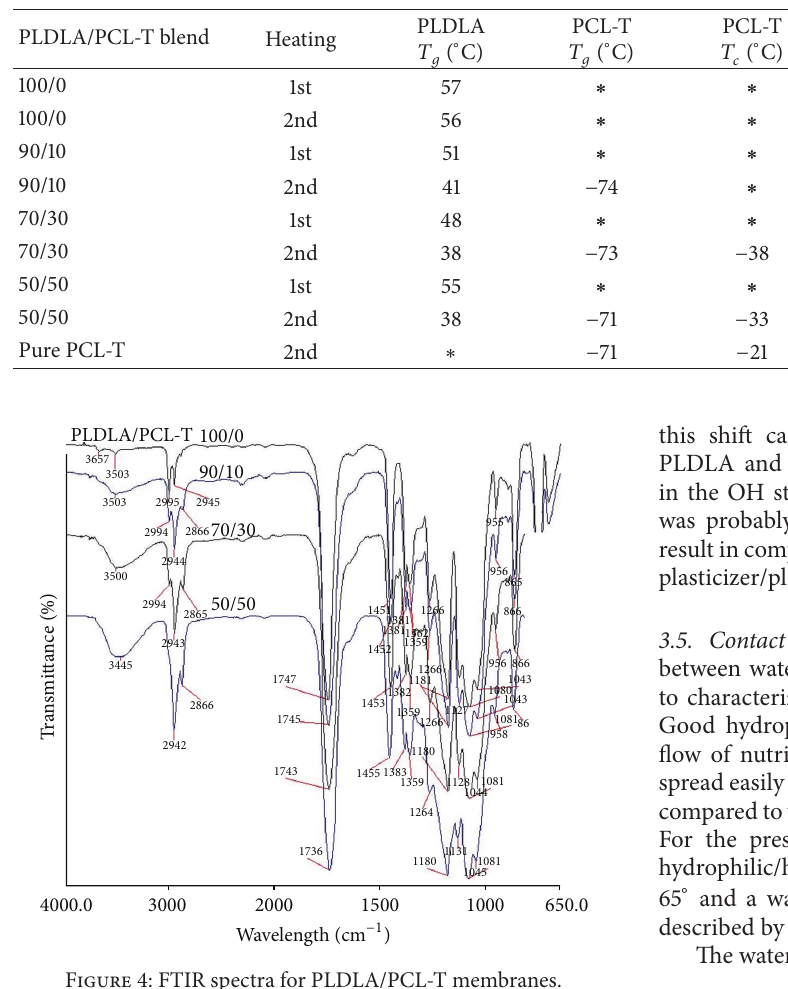
is a consequence of the increased flexibility of the